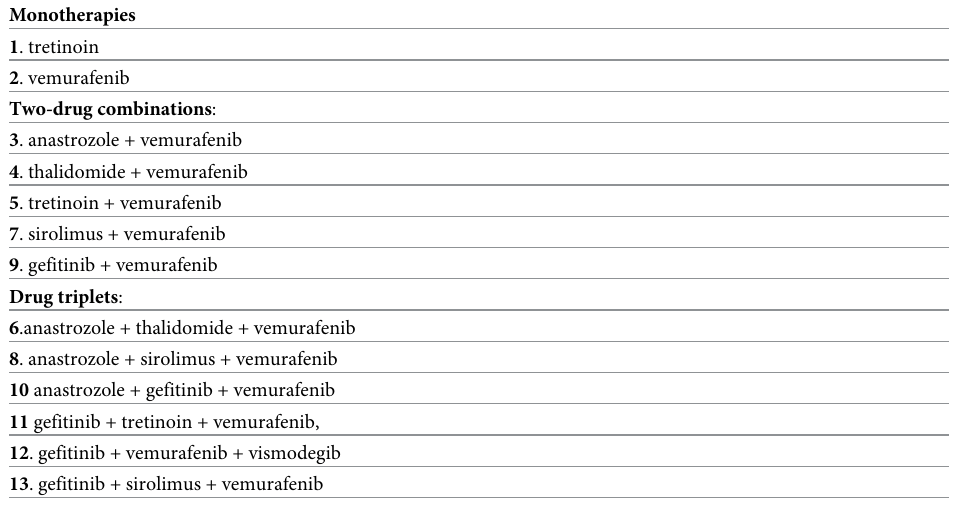
The solutions of the MOPs for combinations of up to two drugs (Fig 2A, S1 Table) and higher-order combinations (Fig 2B, Table 1 and S2 Table) confirm that vemurafenib-gefitinib combination is Pareto optimal regardless of the number of components allowed in combina- tions. Other Pareto optimal combinations involve vemurafenib with anastrozole, tretinoin, Table 1. Selected Pareto optimal combinations for MALME-3M (See S2 Table for the complete list).